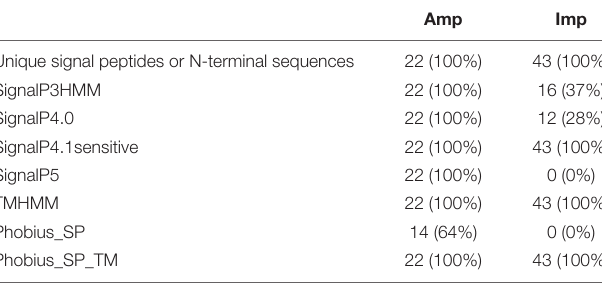
TABLE 8 | Count of positive signal peptide predictions for Amp and Imp sequences.